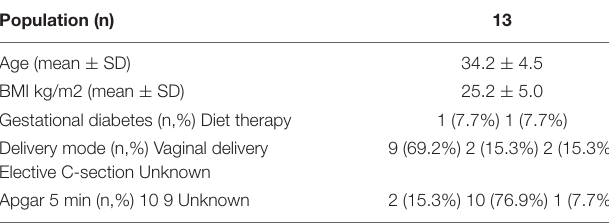
TABLE 1 | Population features analysis and description ( n =